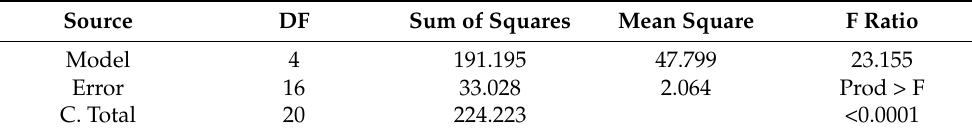
Table 9. Analysis of variance.